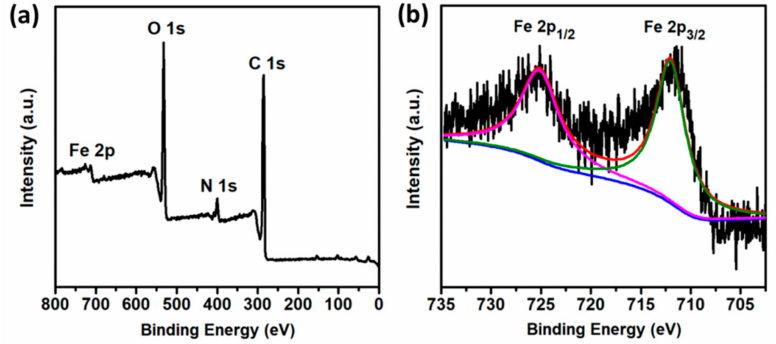
Figure 7. ( a ) XPS full scan spectrum of N-CQDs after addition of Fe 3 + and ( b ) XPS spectrum of Fe